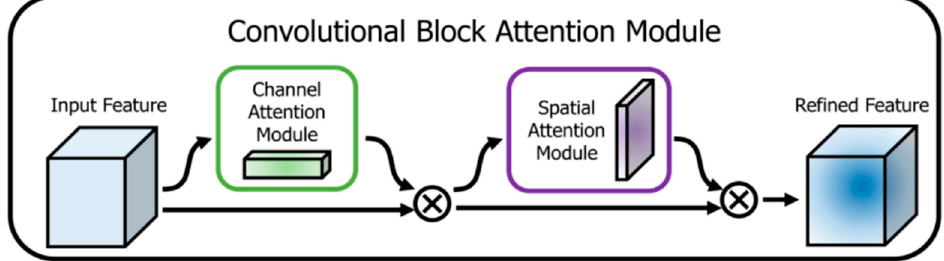
Figure 7. CBAM attention mechanism structure.